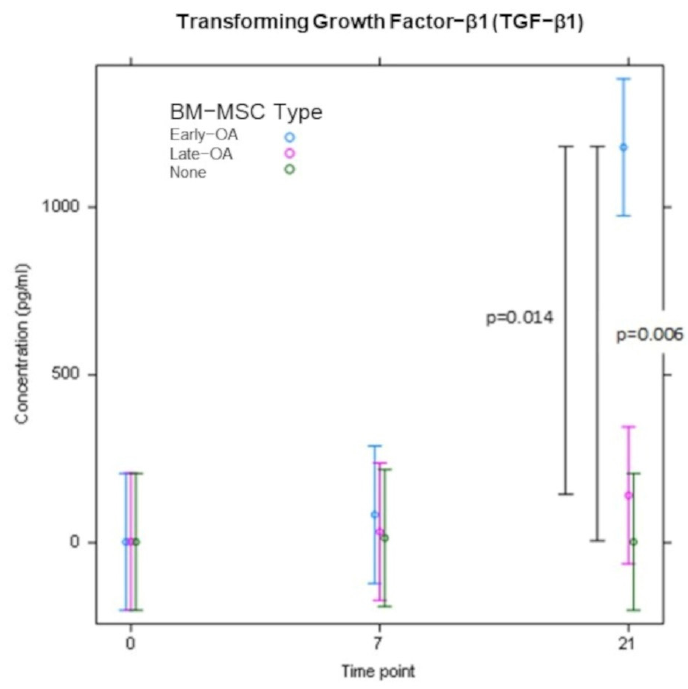
Figure 13. The concentration of MMP-1 and TGF- β 1 in conditioned media at day 0, day 7 and day 21 of the co-culture model, as determined by ELISA. Error bars represent the standard error of the mean. Significant differences are indicated by vertical black bars.